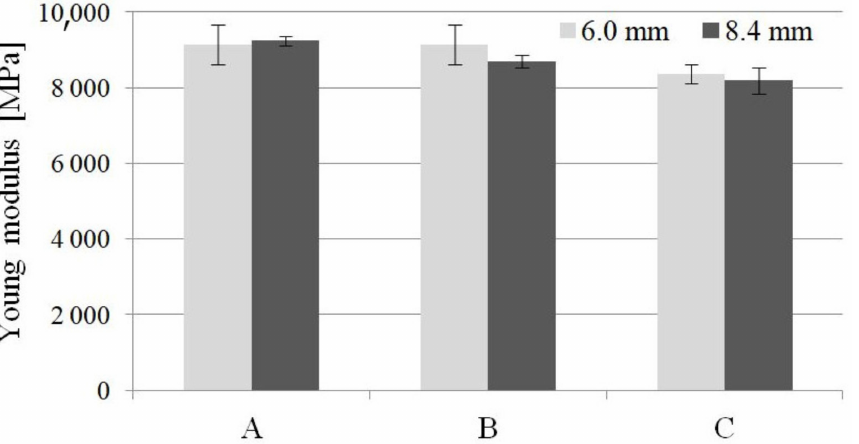
Figure 7. Influence nitrogen pressure on the Young modulus for unfoamed and foamed thick-walled PA66 GF30 molded parts, where A is a solid sample, while B and C are foamed at 16 and 20 MPa nitrogen pressure